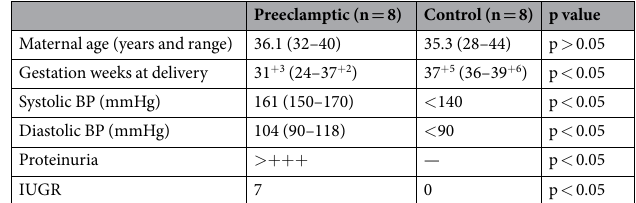
Table 1. Clinical characteristics of recruited